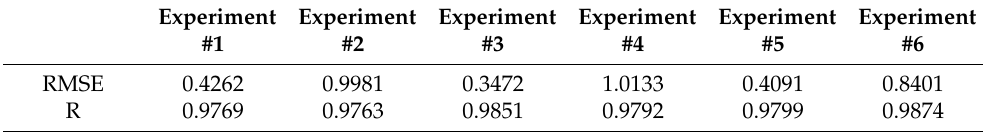
Figure 3. Predicted vs experimental retention times (t R ) for 6 screening conditions. See Table 4 for the details of experiments. Table 3 . Root mean square error (RMSE) and correlation coefficient (R) values for test sets at 6 screening conditions. See Table 4 for the details of experiments.